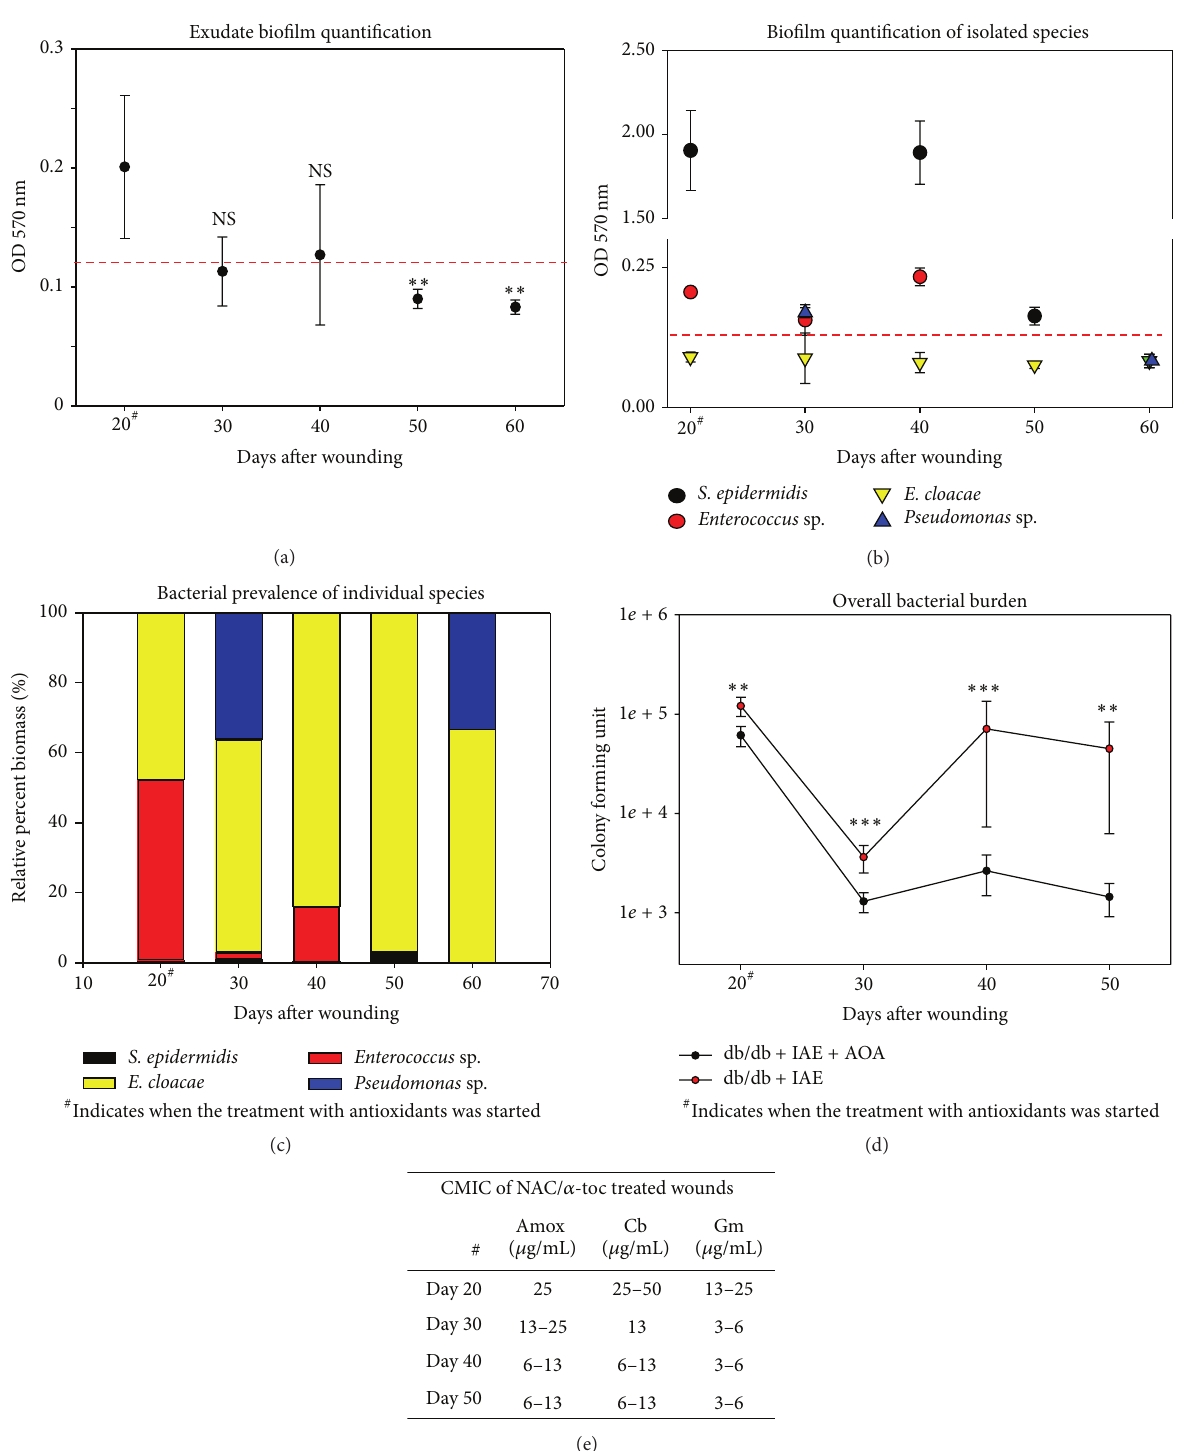
Figure7:AOAtreatmentreducesbiofilm-formingmicrobiotaandincreasesbacterialantibioticsusceptibility:(a)Thebacterialcontentsofthe swabsampleswereevaluatedbymeasuringopticaldensitiesatOD570